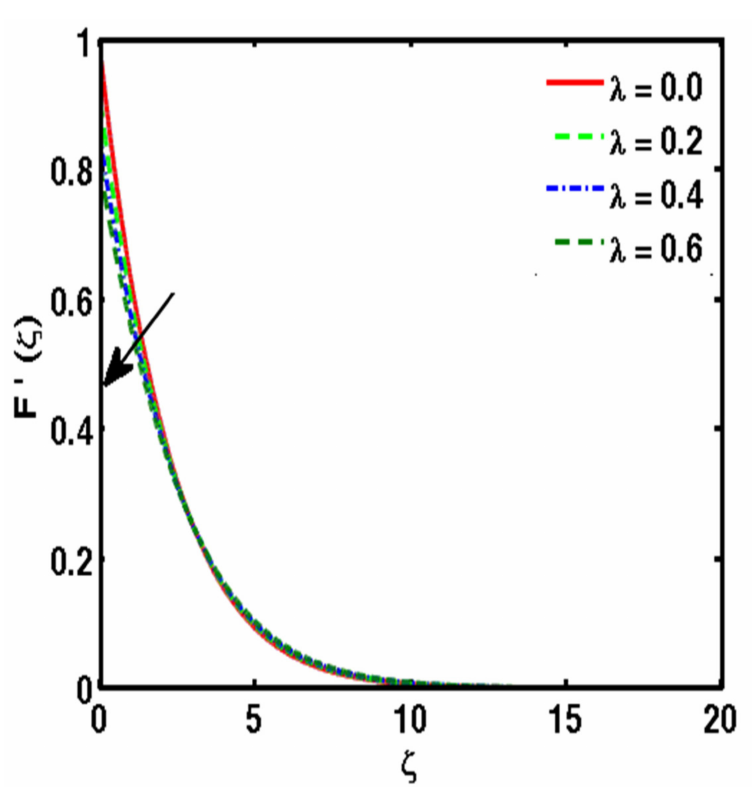
Figure 8. Variation of λ and F (cid:48) ( ζ )